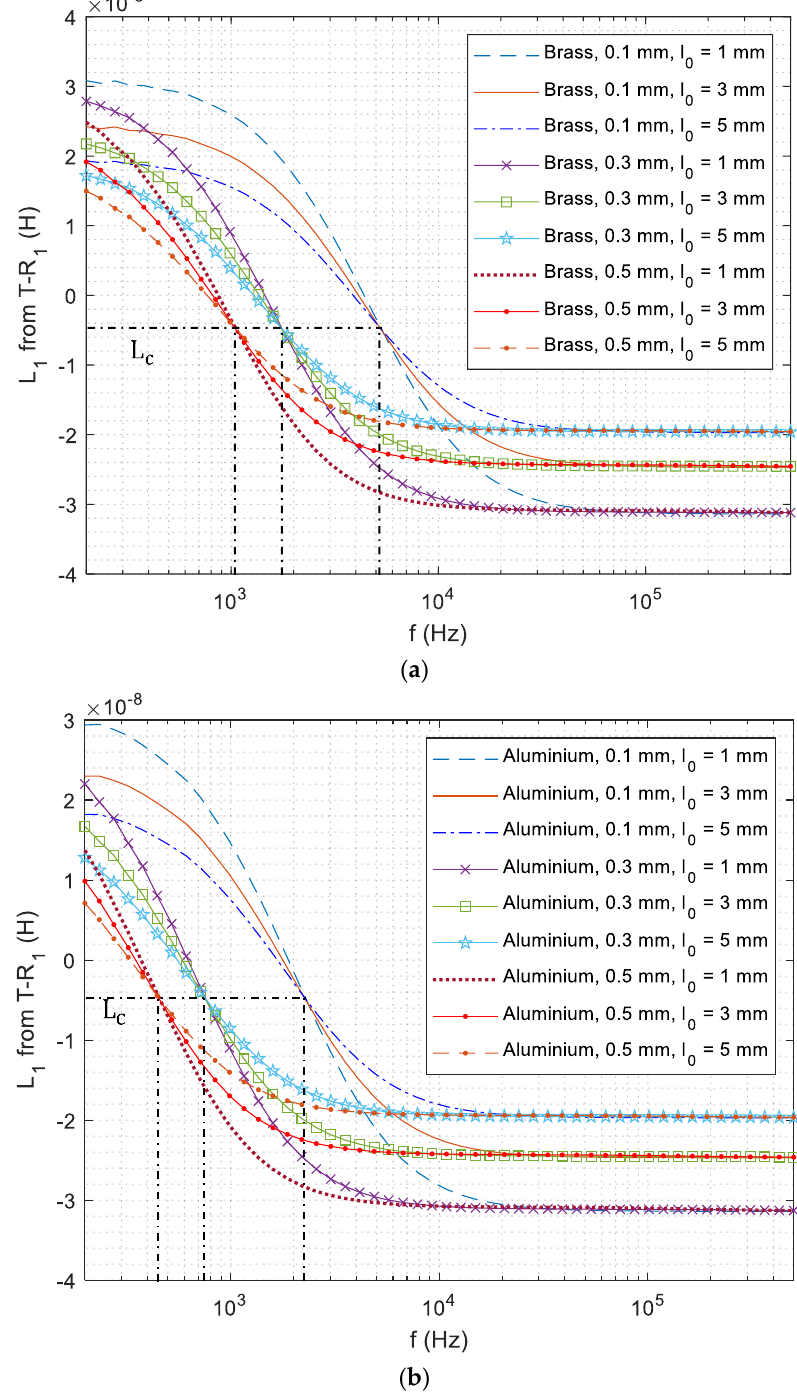
Figure 8. Experimental swept-frequency inductance curves of different lift-off distances for T − R 1 above the conductive coating (on DP 1000 steel) with different thicknesses: ( a ) brass and ( b ) alu- minium.